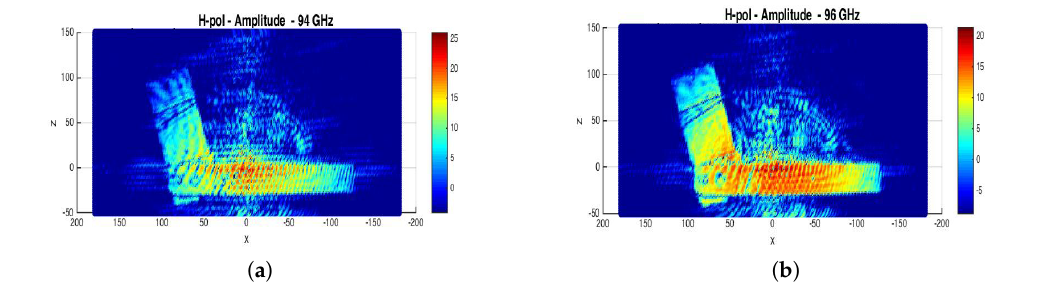
Figure 6. ( a ) smartphone; ( b ) radar acquisition.